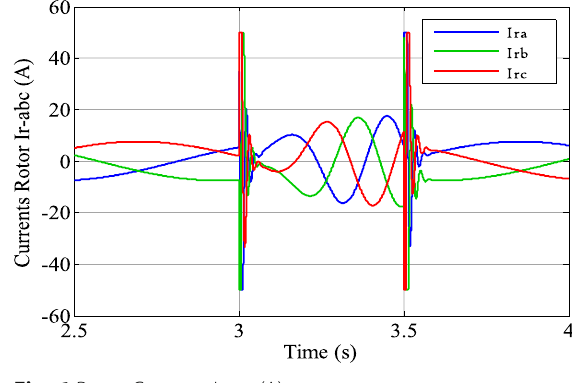
Fig. 6 Rotor Currents I r-abc (A)